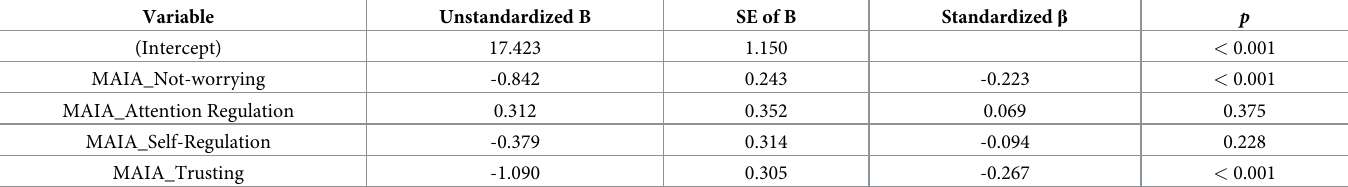
Table 4. Results of multiple linear regression analysis with negative affect as criterion variable.